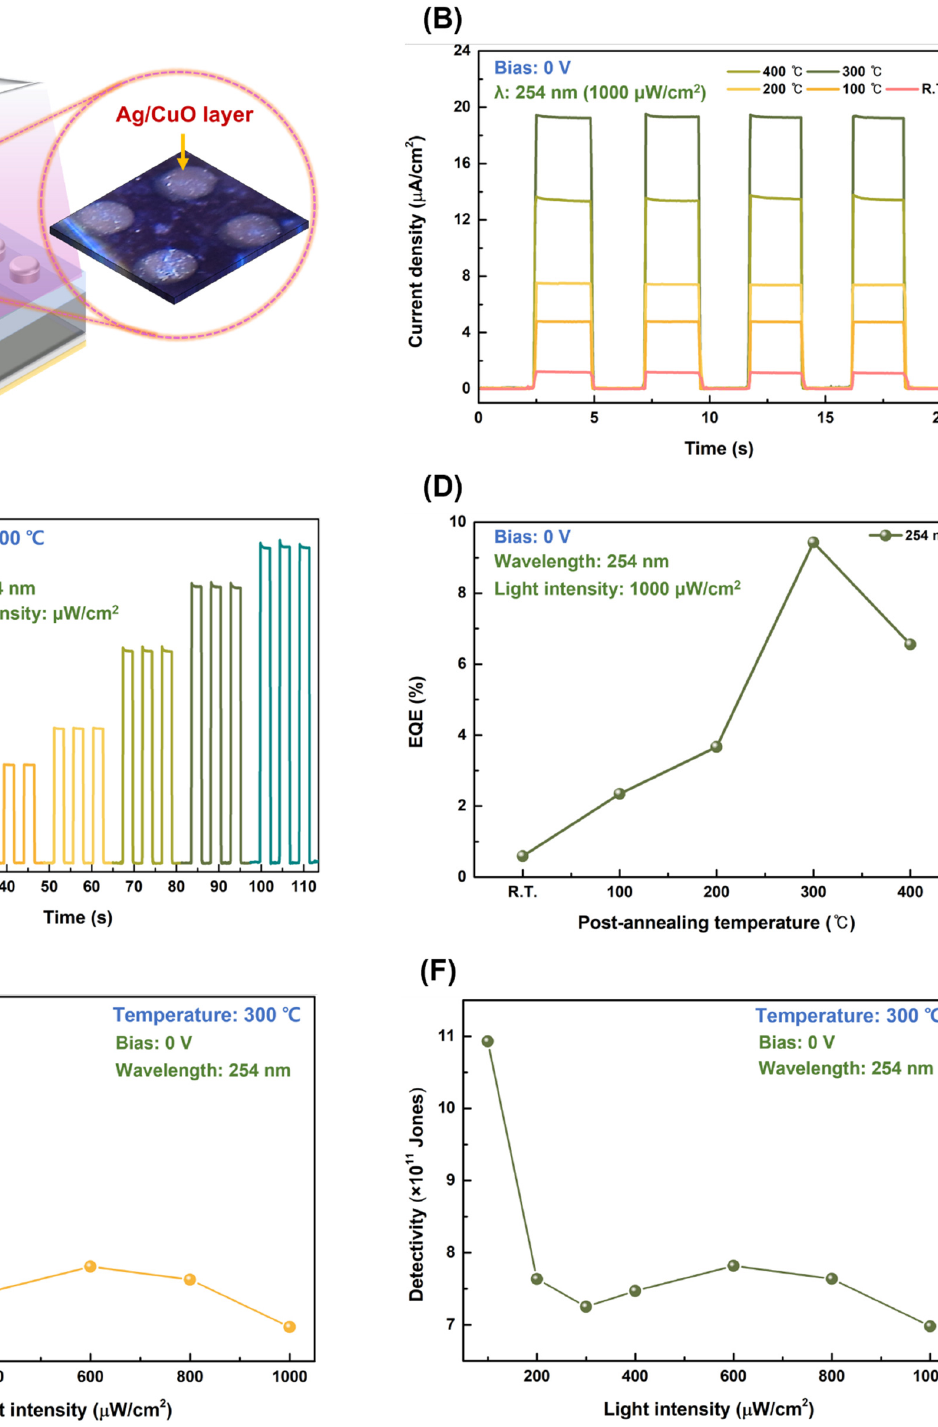
Figure 6. ( A ) Illustration of the as-fabricated CuO/ β -Ga 2 O 3 heterojunction photodetector under 254 nm solar-blind UV light; ( B ) continuous time-dependent photocurrent density characteristics of CuO/ β -Ga 2 O 3 heterojunction photodetectors at zero bias under 254 nm solar-blind UV light with 1000 μ W/cm 2 light intensity; ( C ) time-dependent photocurrent density characteristics of photode- tector postannealed at 300 °C under 254 nm solar-blind UV light with different light intensities; ( D ) postannealing temperature-dependent EQE under 254 nm solar-blind UV light with intensity of 1000 μ W/cm 2 . Variation of ( E ) responsivity and ( F ) detectivity of photodetector with varying light intensity at zero bias.